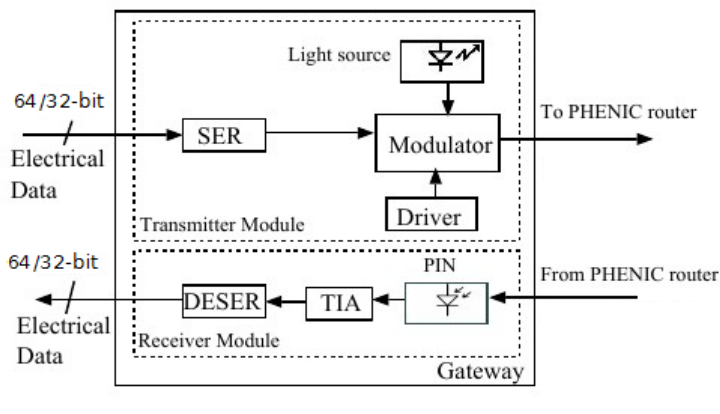
Figure 3. Gateway